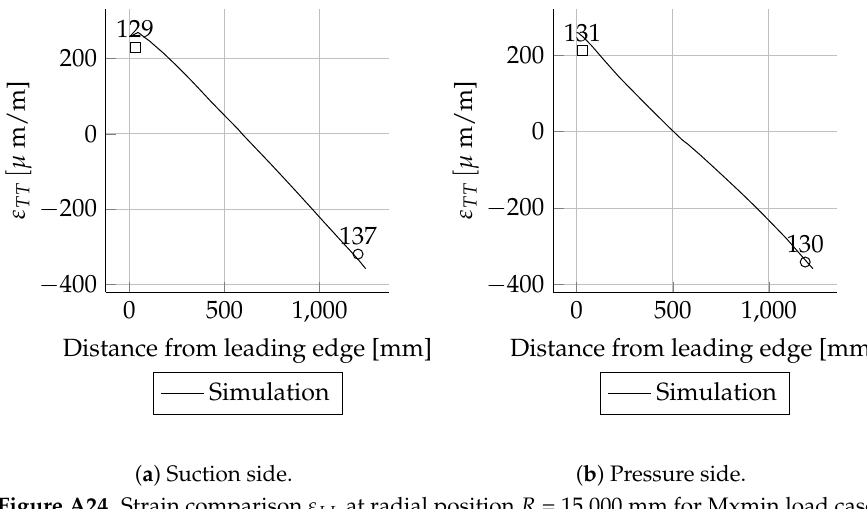
Figure A24. Strain comparison ε LL at radial position R = 15,000 mm for Mxmin load case.